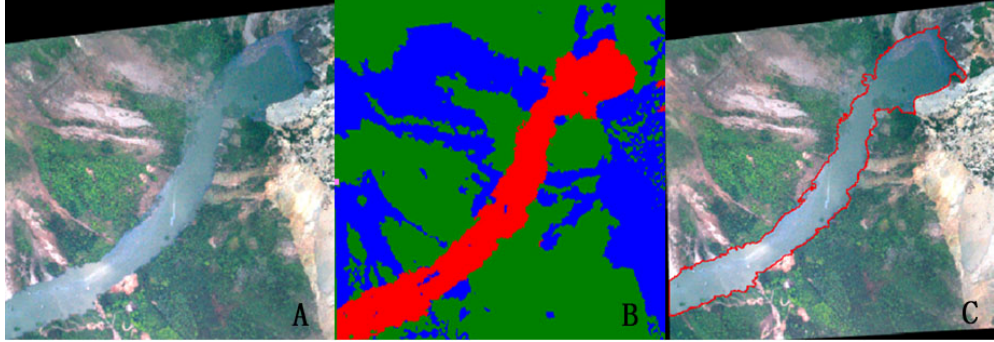
Fig. 4. The boundary extraction of the dammed lake. (a) The original UAV image. (b) The classification results of the UAV image. (c) The extracted scope of the water